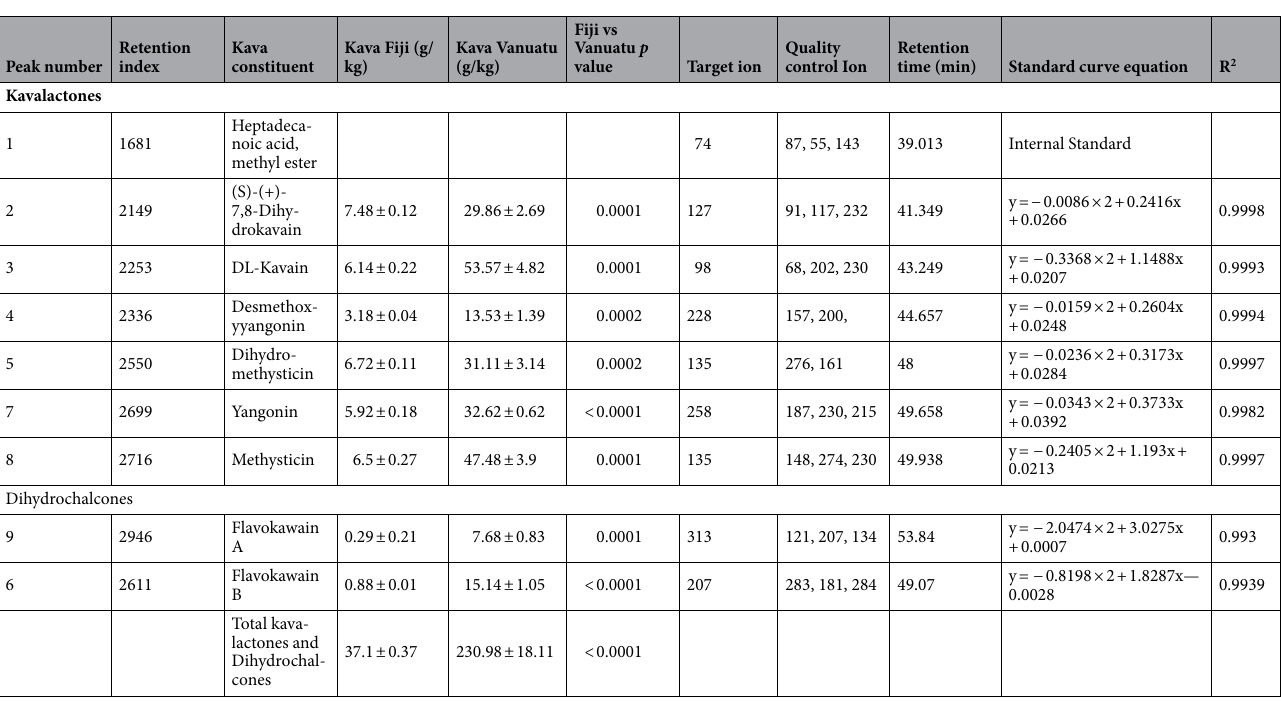
Table 1. Composition of kavalactones and dihydrochalcones in two types of kava samples; Kava Fiji and Kava Vanuatu. Flavokawain C was not detected in either of the